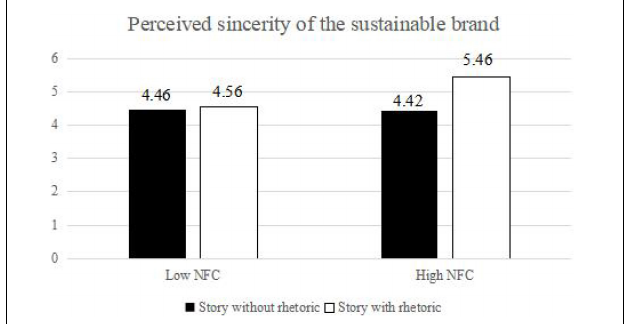
FIGURE 4 | The moderating role of the need for cognition